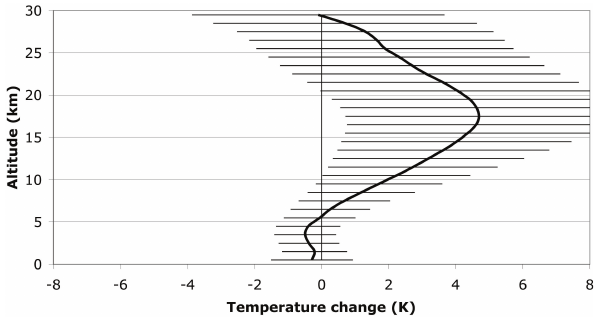
Fig. 4. Vertical profile of the spring (Sep-Oct-Nov) mean ampli- tude of the atmospheric temperature response to volcanic aerosols as estimated by AMOUNTS from the Dumont d’Urville radioson- des database between 1979 and 2008. One-sigma uncertainty esti- mations are